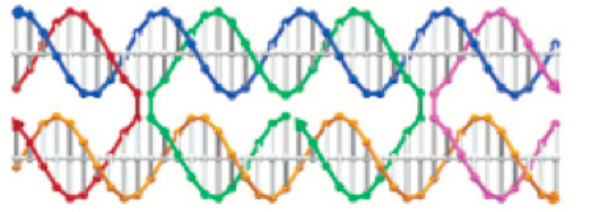
Figure 2. A schematic of DX DNA. Each single strand of DNA is shown in a different color. Small circles represent the position of each phosphate and vertical grey lines represent the base pairs. Note that the red, green, and pink strands cross over between both double helices. Reprinted with permission from Ref. [48] Copyright 2004 American Chemical